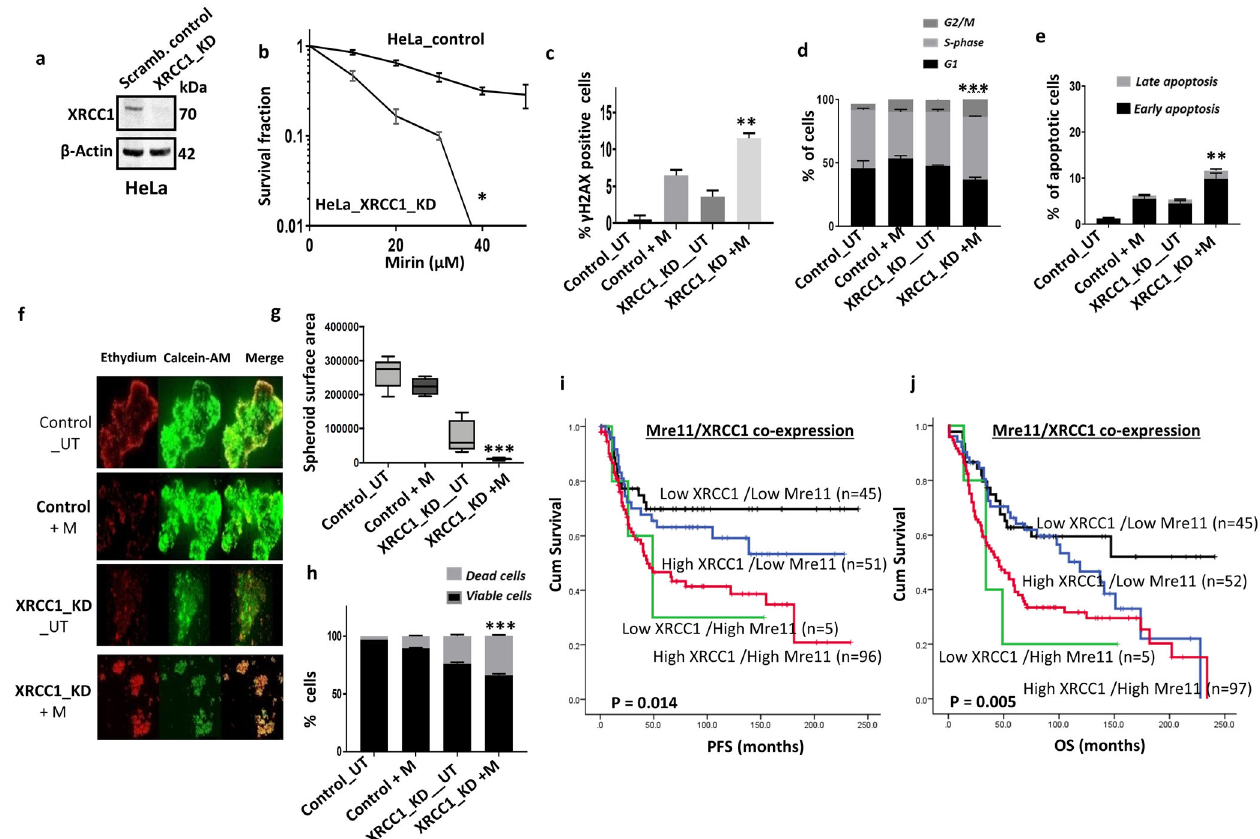
Fig. 5 Mirin induced synthetic lethality in XRCC1 de fi cient HeLa cancer cells. a XRCC1 knock down by sh-RNA in HeLa cells. b Clonogenic survival assay for Mirin sensitivity in HeLa control and HeLa_XRCC1_knock down cells. c γ H2AX positive cells by fl ow cytometry. d Cell cycle analysis by fl ow cytometry. e AnnexinV analysis for apoptotic cells in HeLa control and HeLa_XRCC1_knock down cells treated with 25 μ M Mirin for 24 h. f Representative photomicrographic images for 3D spheroids of HeLa control and HeLa_XRCC1_knock down cells treated with Mirin (25 μ M) for 48 h. Images showing magni fi cation x20. g Quanti fi cation of spheroids size by ImageJ software. h Quanti fi cation of spheroids cell viability by fl ow cytometry. i Kaplan-Meier curve for Mre11&XRCC1 co-expression and progression free survival (PFS) in ovarian cancers. j Kaplan-Meier curve for Mre11&XRCC1 co-expression and overall survival (OS) in ovarian cancers. Figures are representative of three or more independent experiments. Error bars represent standard error of mean between experiments. The P value was calculated as follow, * p > 0.05, ** p > 0.01 and *** p >